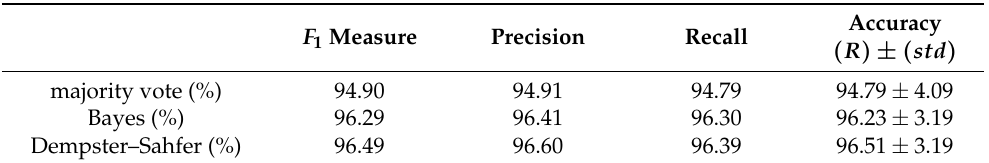
Table 5. F 1 -measure per class, F 1 -measure, precision, recall and average of accuracy rates ( R ) and its standard deviation ( std ) for each model.